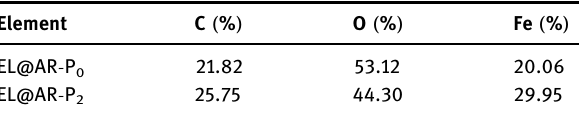
Table 2: Surface chemical composition on tinplate surfaces coated by di ff erent coatings Element